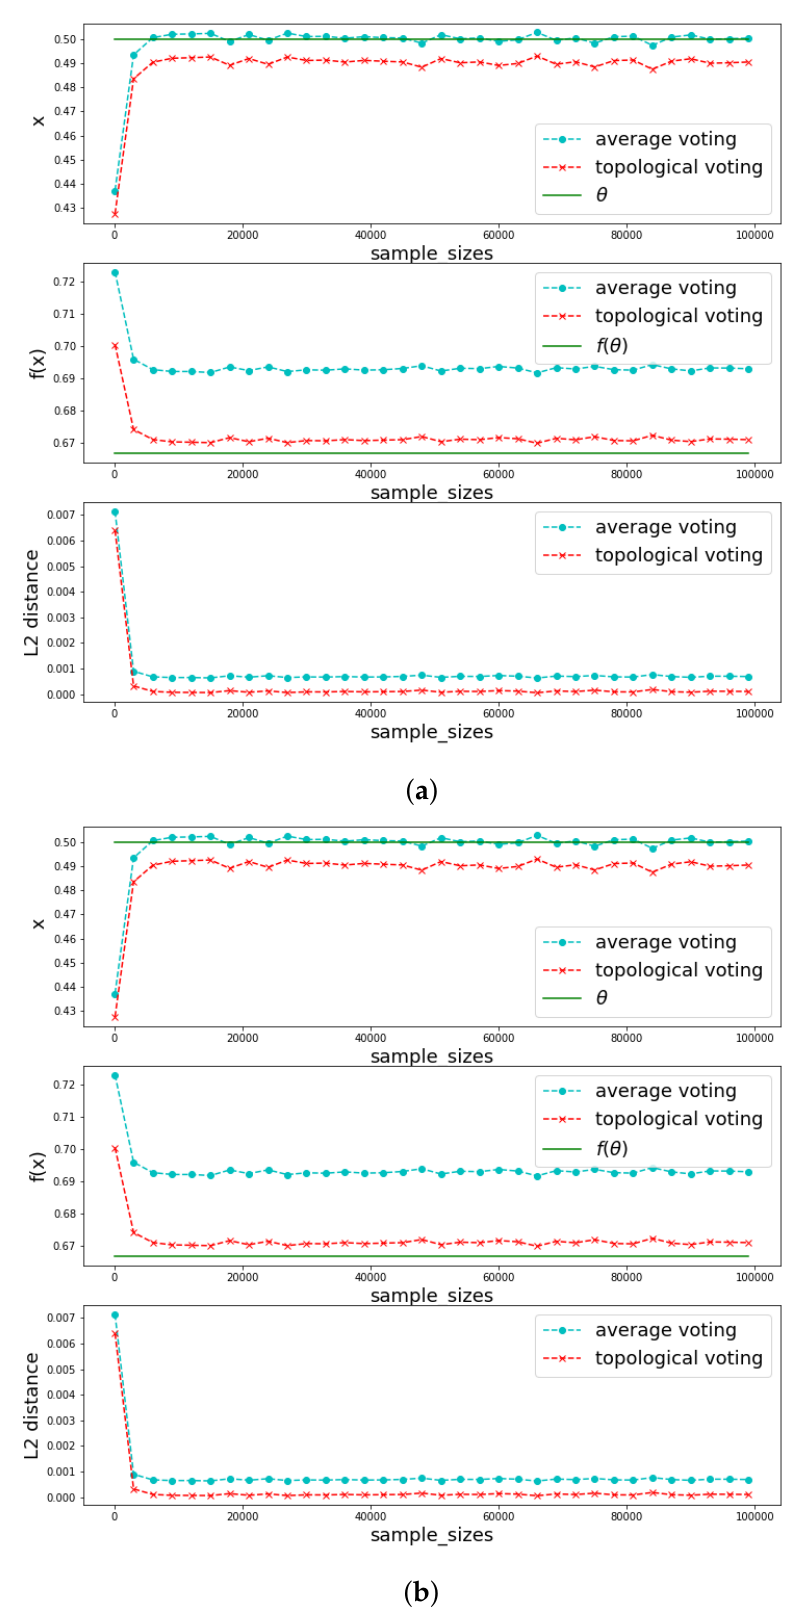
but different f . ( a ) x i i ∼ ∼